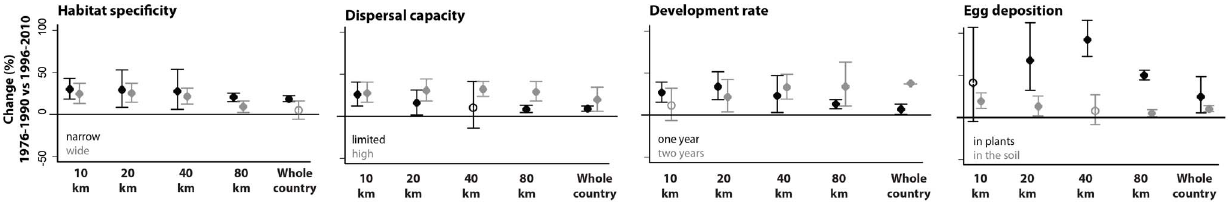
Figure 6.Trends in species richness change ( D S% + 2 95% confidence interval) for the non-food trait based subsets of Orthoptera species. Trends at the 10, 20, 40, 80 km grids and whole country. See table S3 of the supporting material for the numbers of grid cells. Filled symbols indicate change of significantly diffrent from zero; open symbols indicate that change was not significantly different from zero. A pair of results is considered not to be significantly different if the error bars do not overlap.